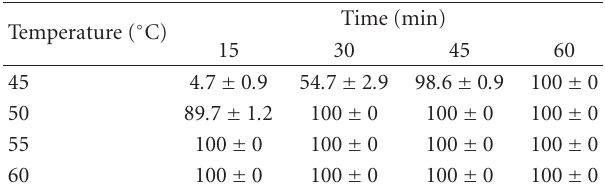
Table 1: Mean ± SE house fly mortality (%) after heat treatment for determination of lethal level of heat.